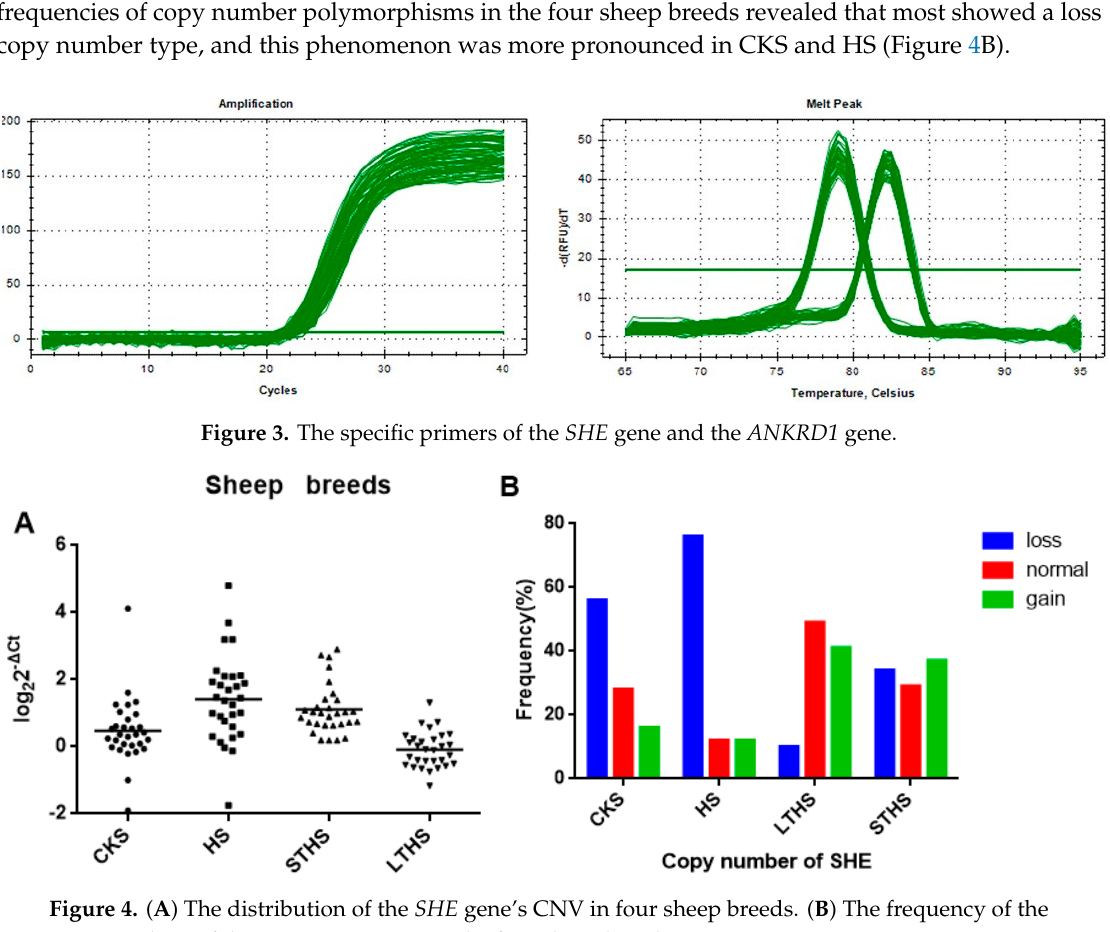
Table 2. Frequency of different CNV types in four sheep breeds.